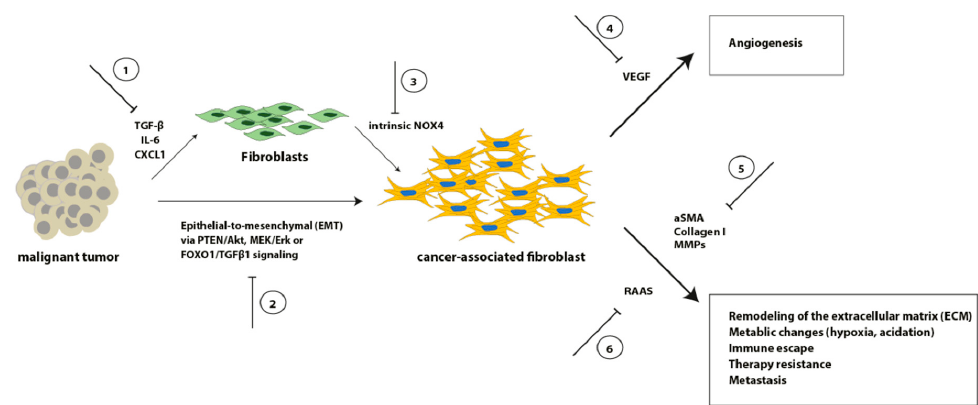
Figure 2. Schematic overview of selected signaling pathways involved in the transformation from fibroblasts into CAFs, as well as representative CAF effects on crucial tumor aspects. Inhibition of these processes ( 1–6 ) might result in novel therapeutic options.